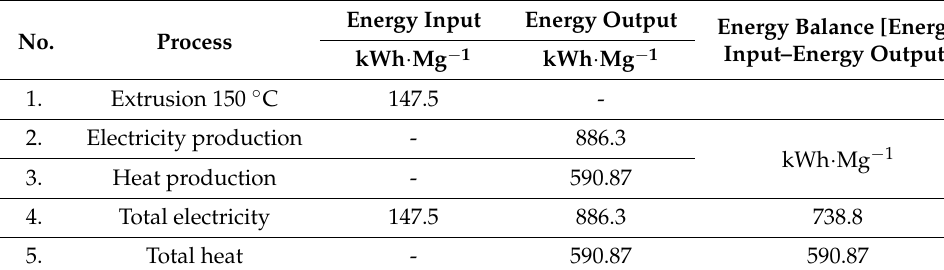
Table 10. The energy balance of biogas generated from Silphium perfoliatum L. extruded at 150 ◦ C.